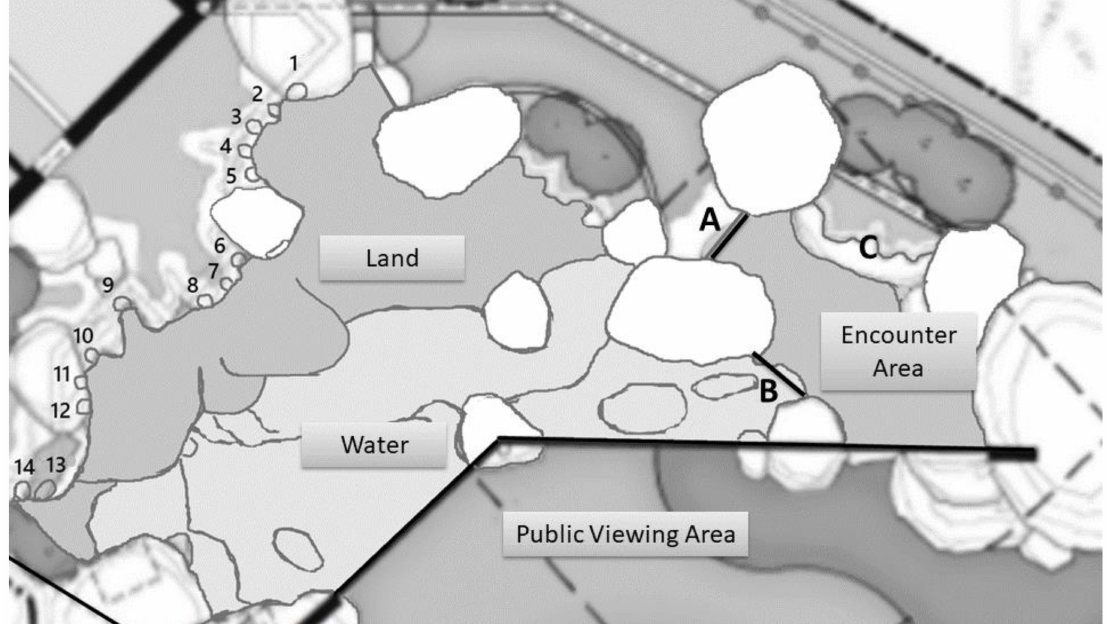
Figure 1. Map of the penguin enclosure. A and B: gates connecting penguin habitat to the encounter area. C: built-in bench for guests. Numbers 1–14 indicate the position of the 14 nest boxes to which the colony had continuous